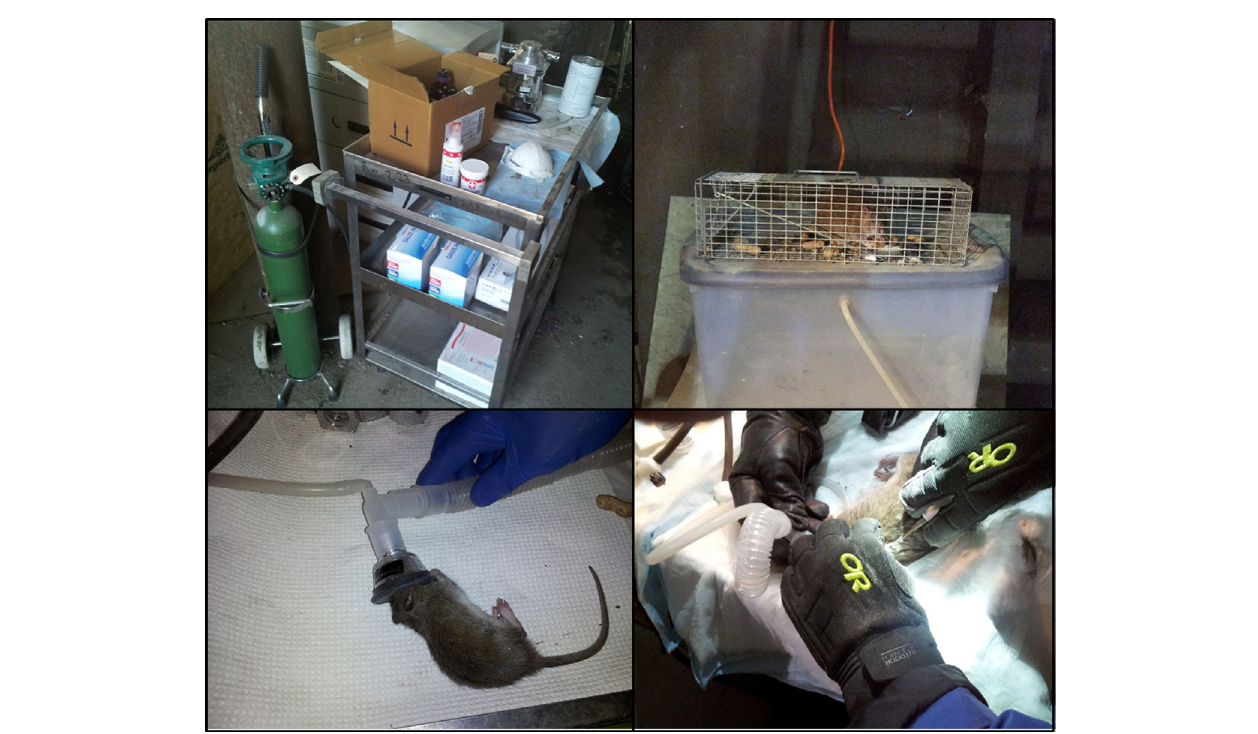
FIGUrE 1 | (A–D) Clockwise from top-left panel. Mobile indoor/outdoor mobile laboratory. Vaporizor and surgical trap with a dual-circuit flow system. (B) Induction chamber. Modified 61 cm × 91 cm oversized Tupperware container. (c) Feline mask and surgical tray. Mask affixed to rat with a strong seal. (D) Microchip implant. Pinch skin between fingers to form a small tent. Insert needle bevel up and